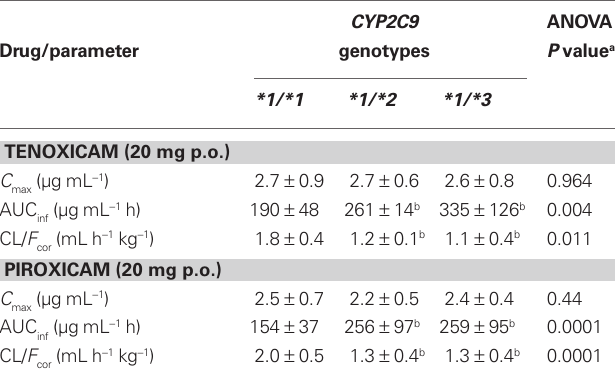
Table 1 | Impact of CYP2C9 polymorphisms on pharmacokinetic parameters for single doses of piroxicam and tenoxicam in healthy Brazilian